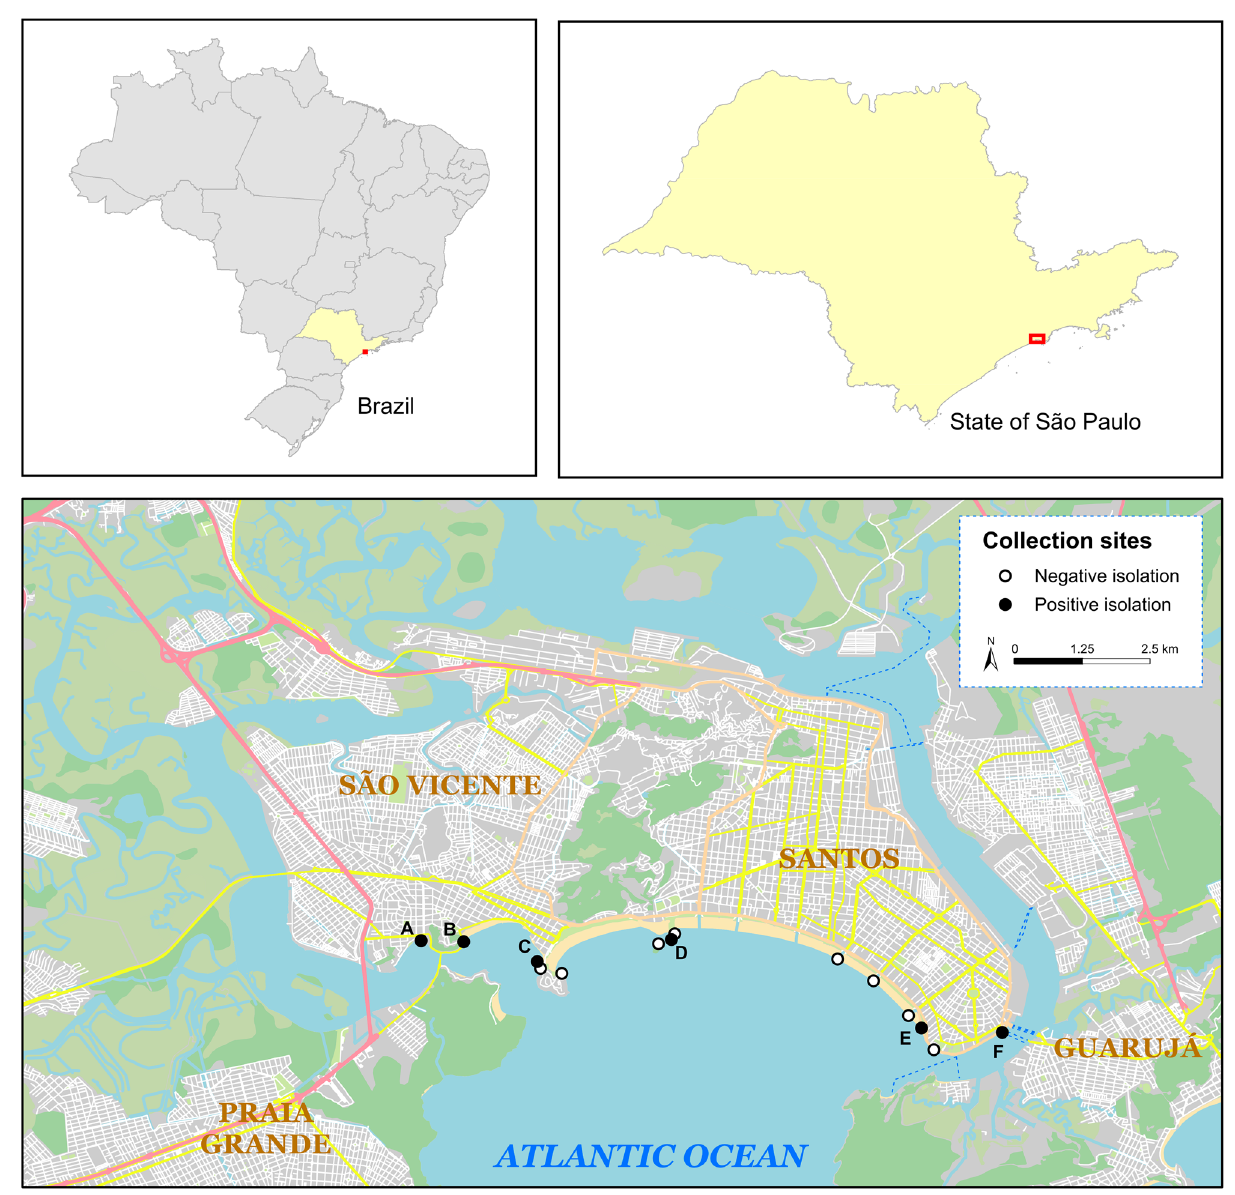
Figure 1. Map showing 14 different collection sites on the coastal areas of São Vicente and Santos cities, Southeast Brazil. Critical priority Enterobacterales strains were isolated from bivalves at 6 of these sites (represented by black markers): ( A )— E. coli TM2CRO [location, −23.972588 S, −46.391932 W]; ( B )— K. pneumoniae JM2CRO [location, −23.972765 S, −46.384877 W]; ( C )— E. coli MM and E. coli MO [location, −23.976040 S, −46.372580 W]; ( D )— E. coli EM1CRO [location, −23.972388 S, −46.350241 W]; ( E )— E. coli C6O and E. coli 6 M [location, −23.987125 S, −46.308609 W]; ( F )— K. pneumoniae BO2 [location, −23.987841 S, −46.295134 W]). The map was generated using public domain shapefiles provided by the Brazilian Institute of Geography and Statistics (https:// www. ibge. gov. br), and OpenStreetMap vector layers